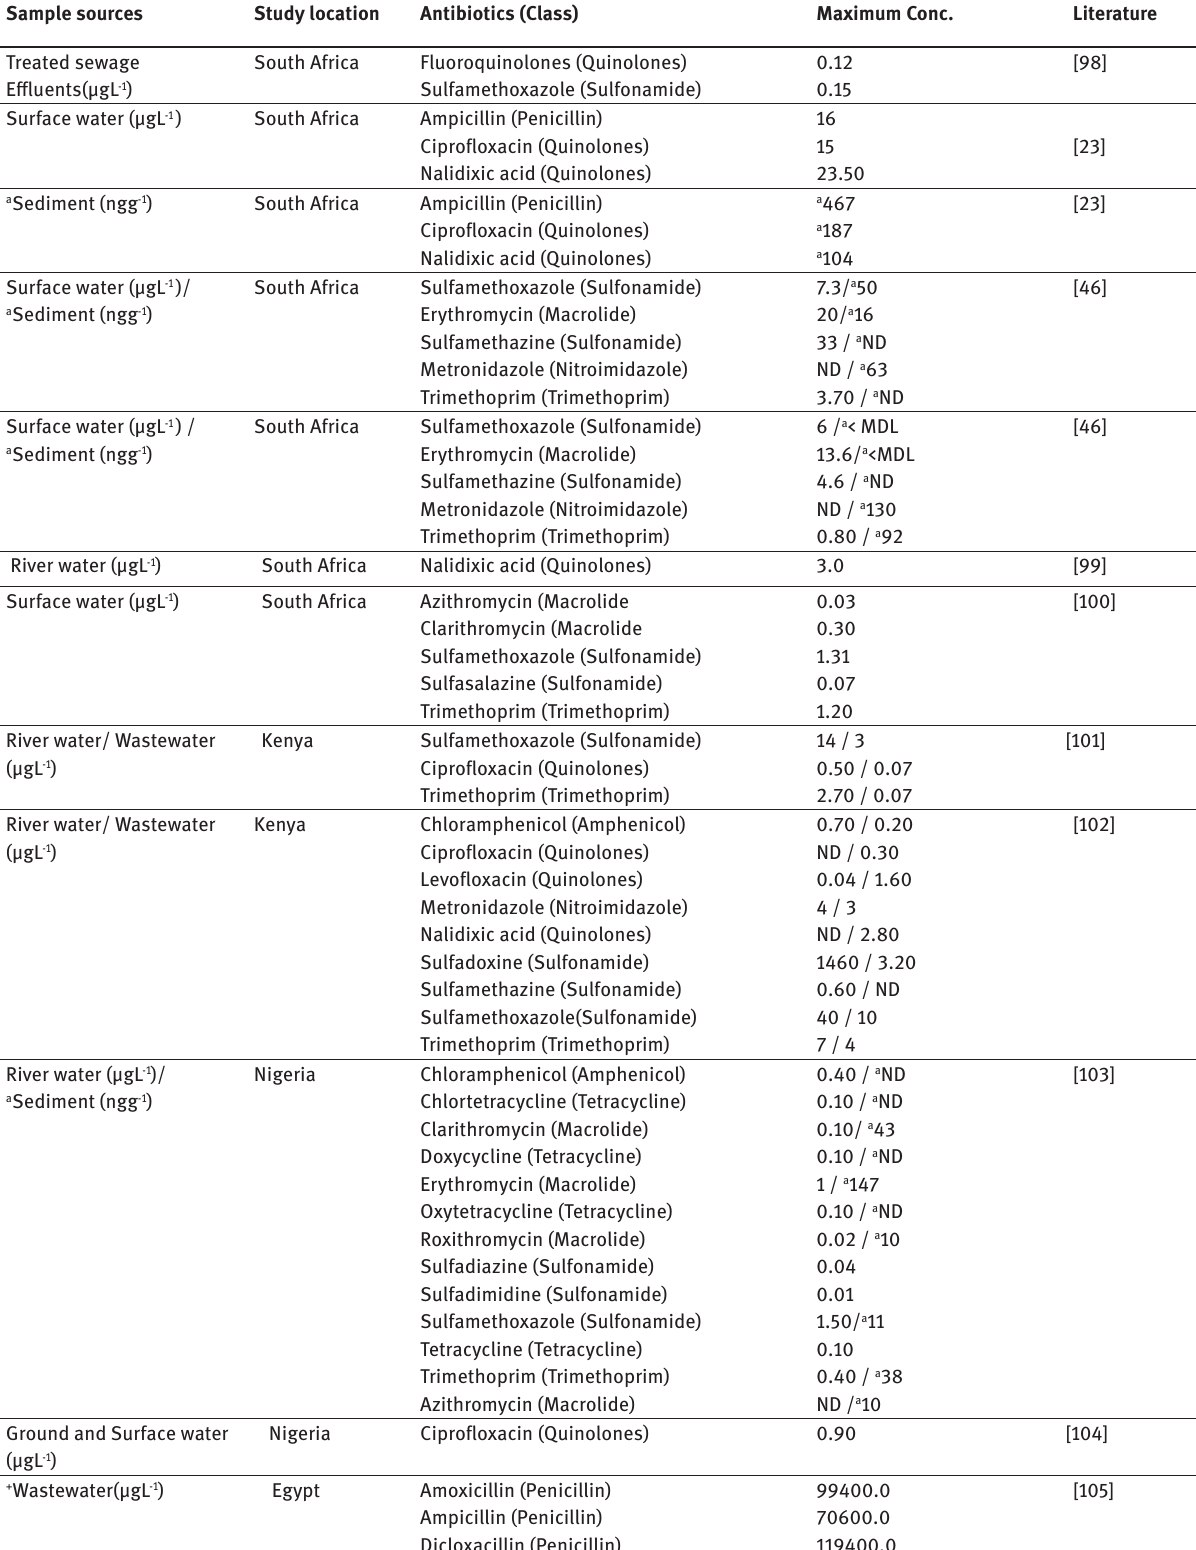
Table 2: Antibiotics and their detected maximum concentrations reported in the environment in Africa (the number of significant digits has been reduced from what was stated in the respective